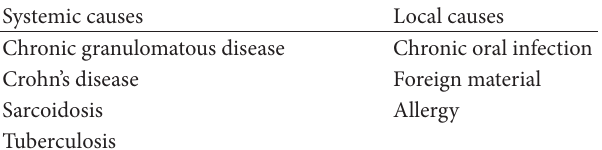
Table 1: Oral granuloma.